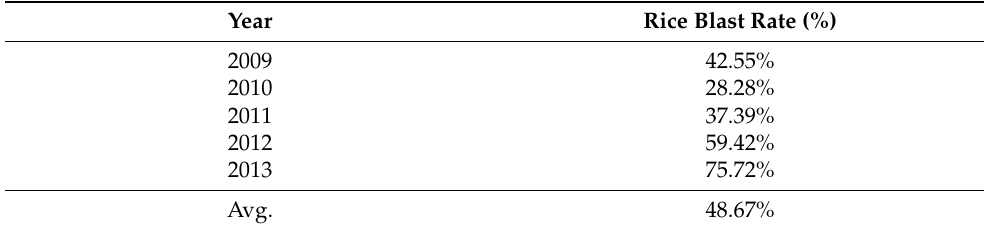
Table 2. The rice blast incidence in the YCN area